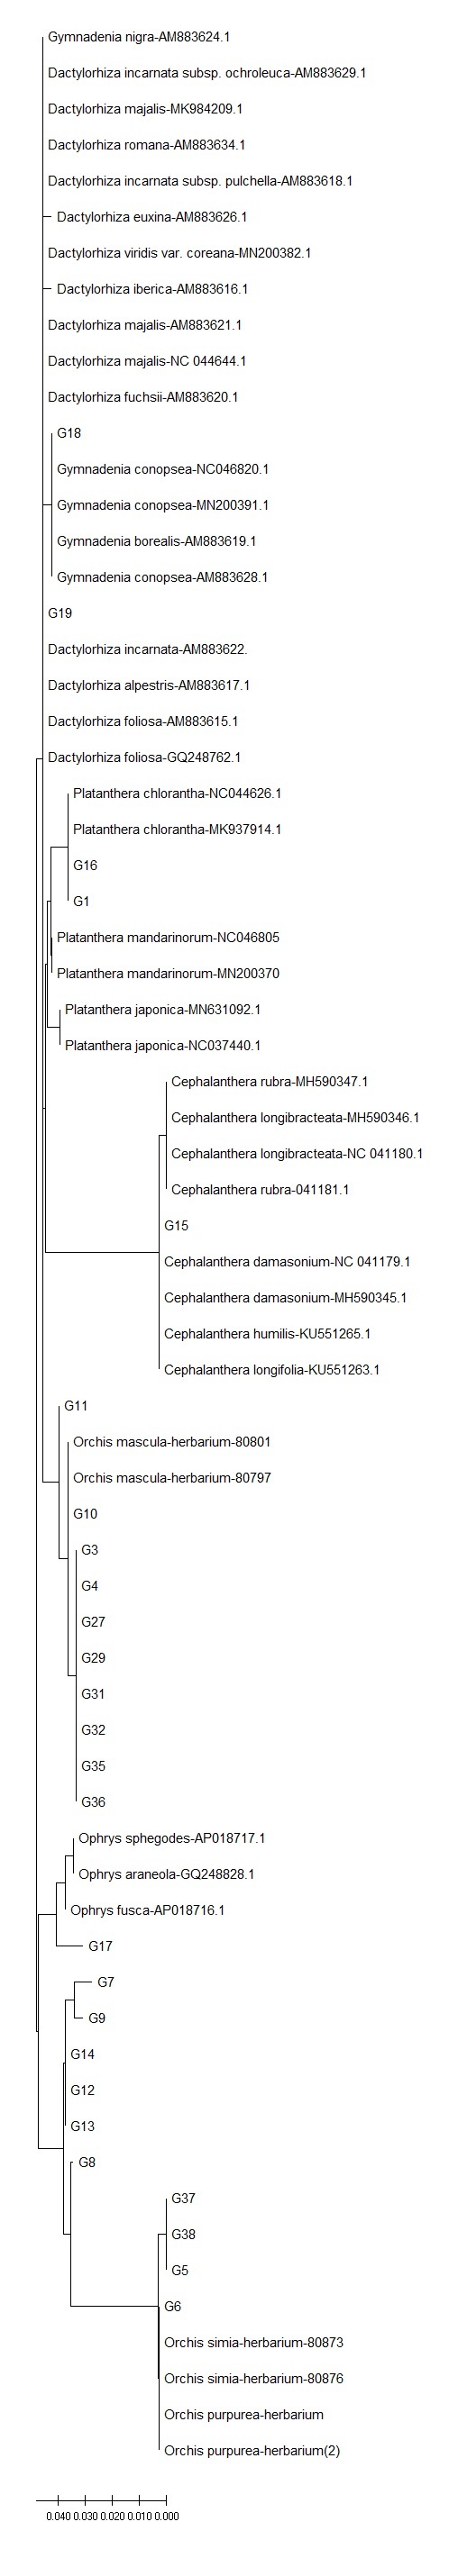
Neighbour-joining phylogenetic tree, based on rpoB sequences of selected orchids. All sequences have been deposited in the Dryad Data Repository - doi: 10.5061/dryad.2ngf1vhmw